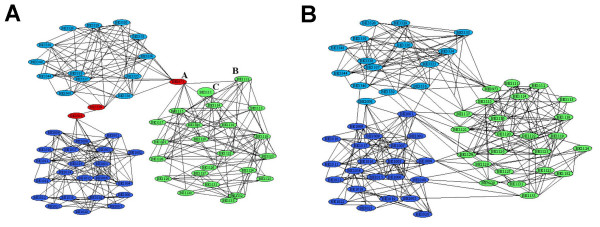
Breaking strategy of large clusters. A breaking strategy was used to reduce the size of large clusters. Each sequence in a cluster was BLASTed against the others and e-values were used to build an adjacency matrix (see Materials and Methods). For example, an e-100 value will result in a distance of 1 cm between two sequences. Only values below e-25 were used for graphical display. GRAPH9 was used to flag bridges (articulation points where an EST links two potential sub-clusters) and manually split a cluster into distinct sub-clusters. A) Example of a cluster region where specific ESTs (in red) can be manually transferred to sub-clusters (based on the smallest e-value). B) Example of a cluster region that could not be broken into sub-clusters due to the complex interrelations between ESTs.